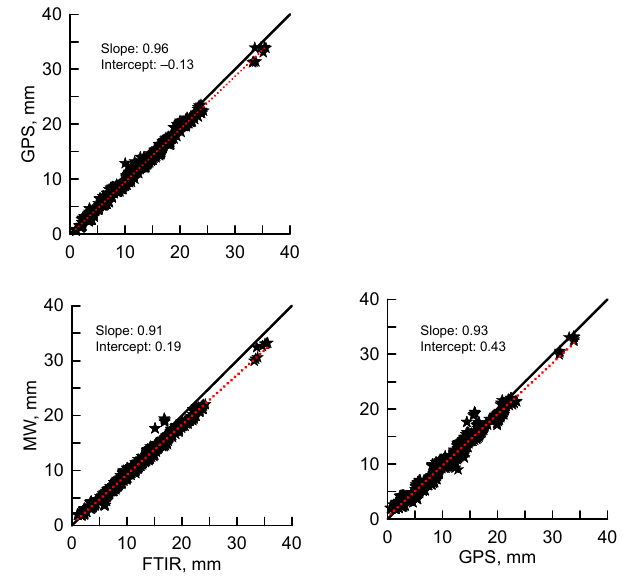
Figure 7. Correlation of IWV values measured by the FTIR, GPS, and MW techniques. Red dotted line is the linear regression line. The slope and intercept of the linear regression line are given in each